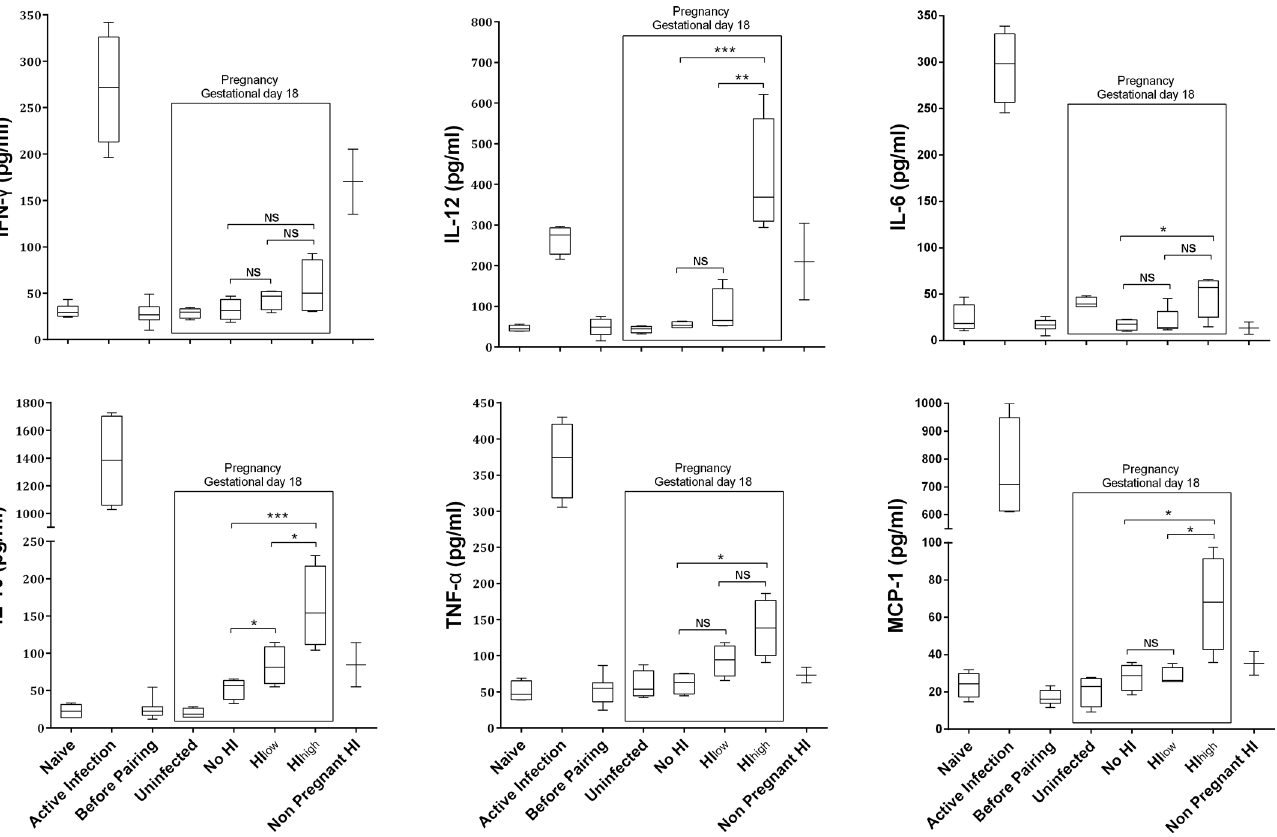
Fig 4. Peripheral cytokine responses in P . chabaudi re-infected or never-infected pregnant mice, and in non-pregnant re-infected mice. Cytokines were measured at sequential time-points before ( “ Na ï ve ” ) and during infection ( “ Active Infection ” ), prior to pregnancy ( “ Before Pairing ” ), and then at gestational day 18 for all pregnant mouse groups ( “ Uninfected ” , “ HI low ” , “ HI high ” and “ No HI ” ) and simultaneously in re-infected non-pregnant control mice (Non Pregnant HI). (A-F) Cytokines IFN- γ , IL-12, IL-6, IL-10, TNF- α and MCP-1 were measured using Milliplex Map Mouse cytokine kit. Data were analyzed by one-way ANOVA using Bonferroni test to correct for multiple comparisons, and are presented as box and whiskers plots showing min and max values. * P < 0.05, ** P < 0.01, *** P < 0.001 and NS = not significant.